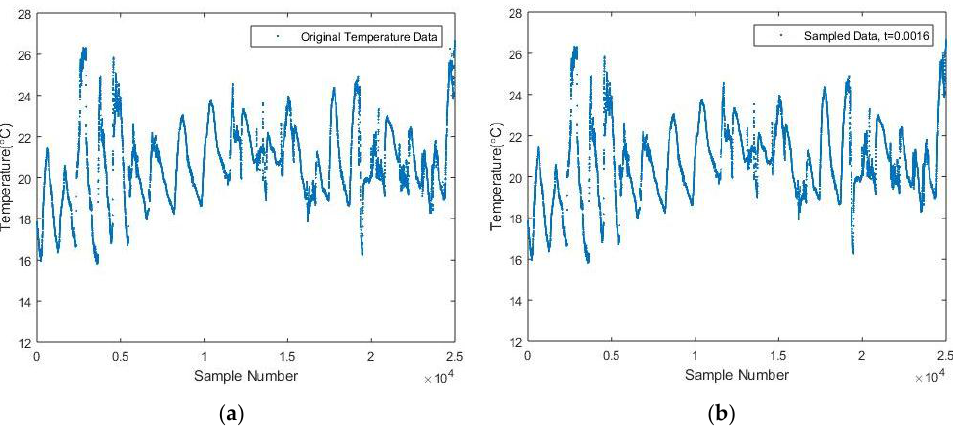
Figure 10. ( a ) Original Temperature data from Intel Berkeley Research Lab; ( b ) Sampled Temperature data with 0.0016.